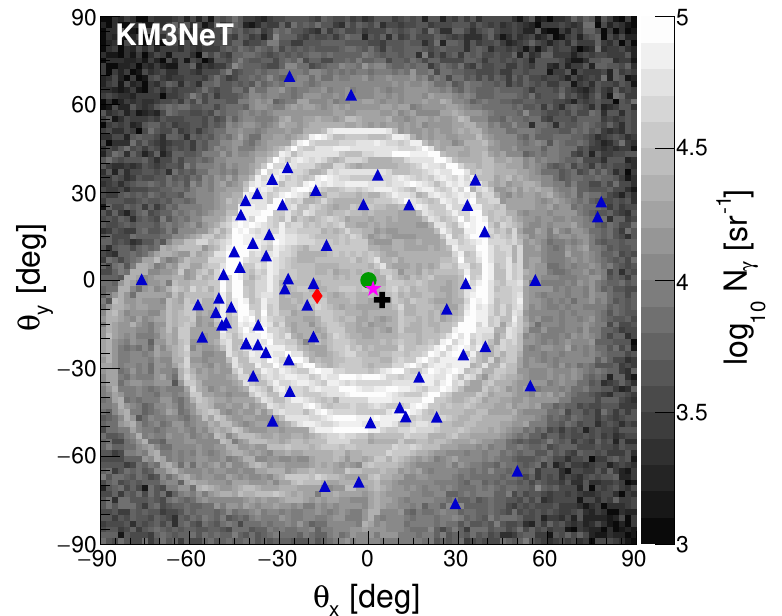
Figure 6 . Photon distributions from a hadronic cascade with E h = 10 GeV. The true cascade direction is in the ~u z direction, at ( (cid:18) x ; (cid:18) y ) = (0 ; 0) (green circle). The mean photon direction, averaged over 1000 simulation iterations with the same hadronic (cid:12)nal state, is given by the purple star | the 3 (cid:14) o(cid:11)set from (0 ; 0) re(cid:13)ects the intrinsic bias for this particular state. The distribution of all emitted photons for one particular propagation iteration is shown by the grey shading. The mean direction of all these photons is given by the black plus sign | the 8 (cid:14) o(cid:11)set of this from (0 ; 0) measures the total intrinsic variation in the case of the all-photon limit, while the 5 (cid:14) o(cid:11)set from the purple star measures the variation due to random particle propagation only. A random sample of unscattered photons, chosen according to the probabilities of (cid:12)gure 2, are shown by blue triangles, along with their mean direction (red diamond). The 25 (cid:14) o(cid:11)set of the red diamond from the black cross measures the variation due to photon sampling only, while the o(cid:11)set of 18 (cid:14) from (0 ; 0) gives the overall